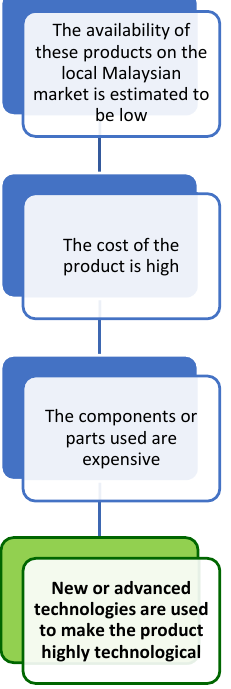
Figure 8. CEC analysis for constraint 3.